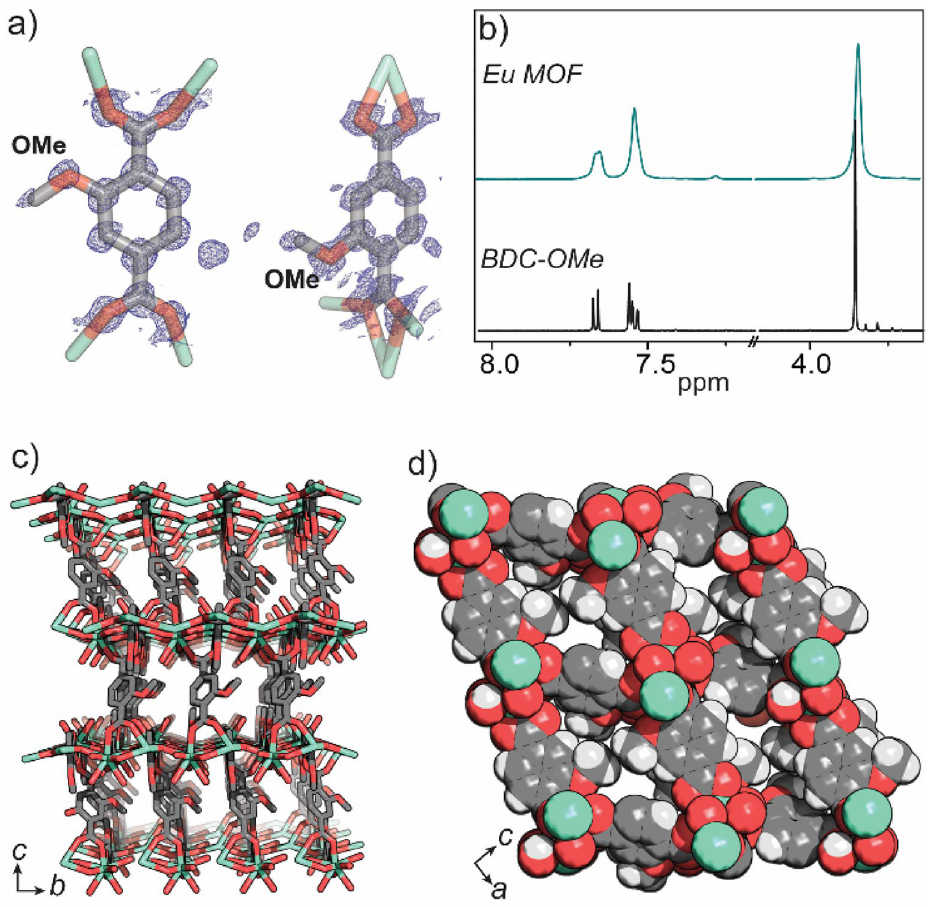
Figure 1. ( a ) an overlay of the F obs map (blue) and BDC-OMe ligand as present in EuBDC-OMe; ( b ) 1 H NMR spectra (500 MHz, DMSO-d 6 /4% DCl) showing the BDC-OMe ligand (bottom) and the digested EuBDC-OMe MOF (top); ( c ) synchrotron X-ray skeletal structure of EuBDC-OMe viewed along the c axis and ( d ) space- filling structure viewed along the b